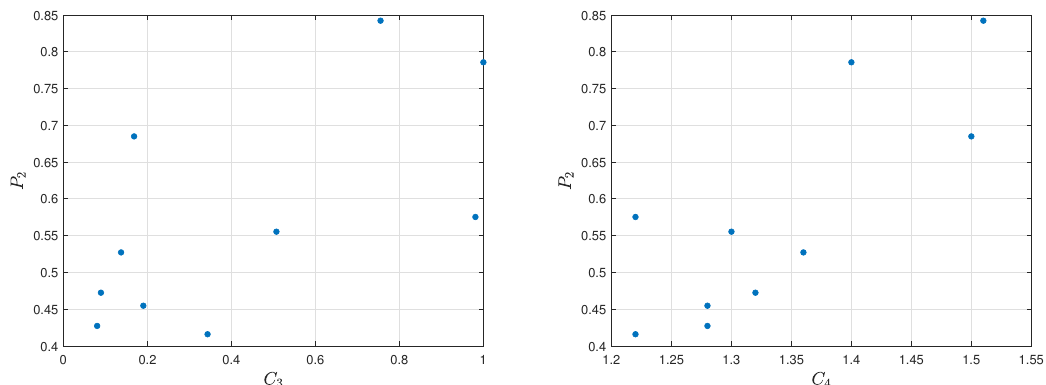
Figure 11. The relation diagram of Total kills ( C 3 ) for assessment P 2 ( left side ) and K/D Ratio ( C 4 ) for assessment P 2 ( right side ).